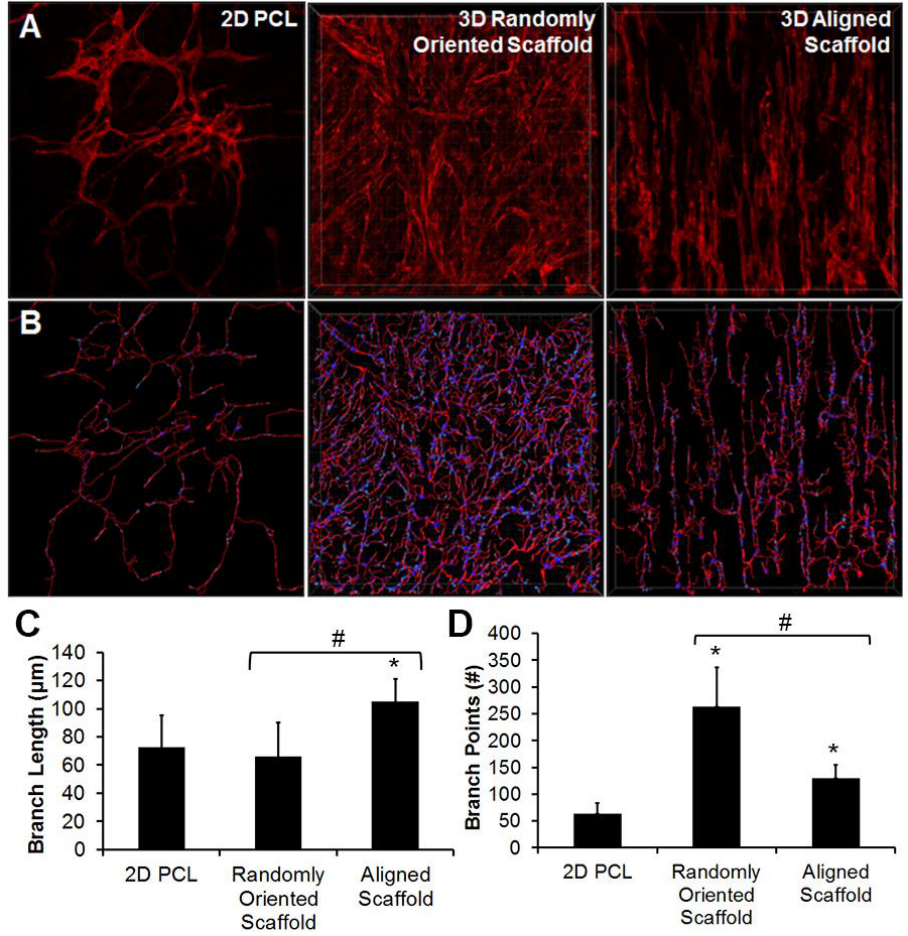
Figure 2. Vascular network-like formation in 3D microfibrous scaffolds. ( A ) 3D stacked confocal images of CD31 staining in 2D PCL film, 3D randomly oriented scaffold, and 3D aligned scaffold. ( B ) Transformation of CD31 expression into skeletonized filaments; ( C , D ) Quantification of branch length ( C ) and branch points ( D ). * indicates statistically significant relationship to 2D polycapro- lactone (PCL) film, and # indicates statistically significant comparison between 3D groups. p < 0.05 (n = 5). Reproduced with permission from